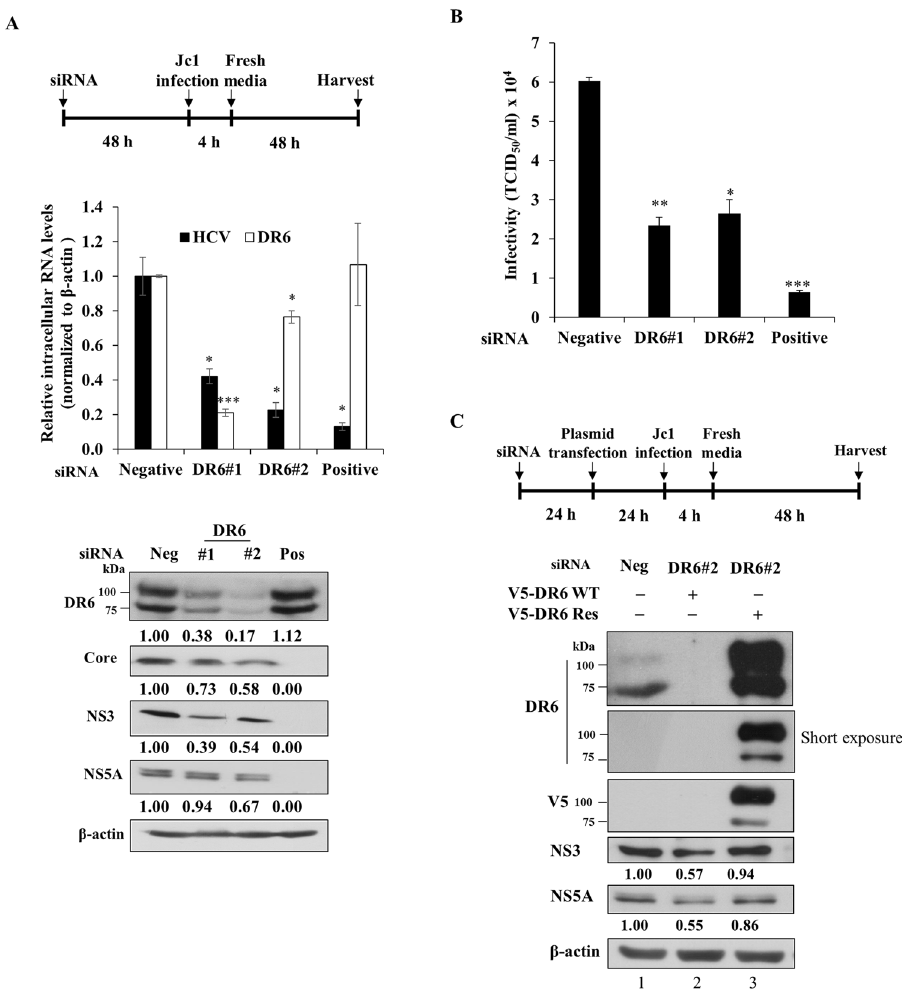
Figure 6. DR6 is required for HCV propagation. ( A ) (Top panel) Schematic illustration of the experimental design. Huh7.5 cells were transfected with 20 nM of the indicated siRNAs. At 2 days after siRNA transfection, cells were infected with Jc1. At 48 h postinfection, both RNA (middle panel) and protein levels (bottom panel) were analyzed by qRT-PCR and immunoblot assay using the indicated antibodies, respectively. The asterisks indicate significant differences ( * P < 0.05; * * P < 0.01; ** * P < 0.001) from the value for the negative control. Neg, negative universal control siRNA; Pos, positive HCV-specific siRNA targeting the 5 ′ nontranslated region (NTR) of Jc1. ( B ) Huh7.5 cells were transfected with 20 nM of the indicated siRNAs. At 2 days after transfection, cells were infected with green fluorescent protein-tagged Jc1. At 48 h postinfection, HCV infectivity was determined by limiting dilution assay. Infected cells were assessed by fluorescent microscope. TCID 50 , tissue culture infectious dose 50%. ( C ) (Upper panel) Schematic illustration of the experimental design. (Lower panel) Huh7 cells were transfected with the indicated siRNAs. At 24 h after siRNA transfection, cells were further transfected with either wild-type or siRNA-resistant DR6 mutant plasmid and followed by Jc1 infection. At 48 h postinfection, cell lysates were immunoblotted using the indicated antibodies. Res, V5-tagged siRNA-resistant mutant of DR6. Protein band intensities were analyzed by using ImageJ. All experiments were performed in